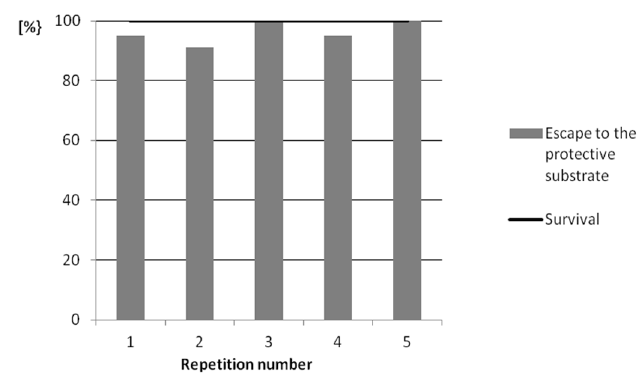
Figure 4. Reaction of E. fetida individuals to the stressor and their survival.